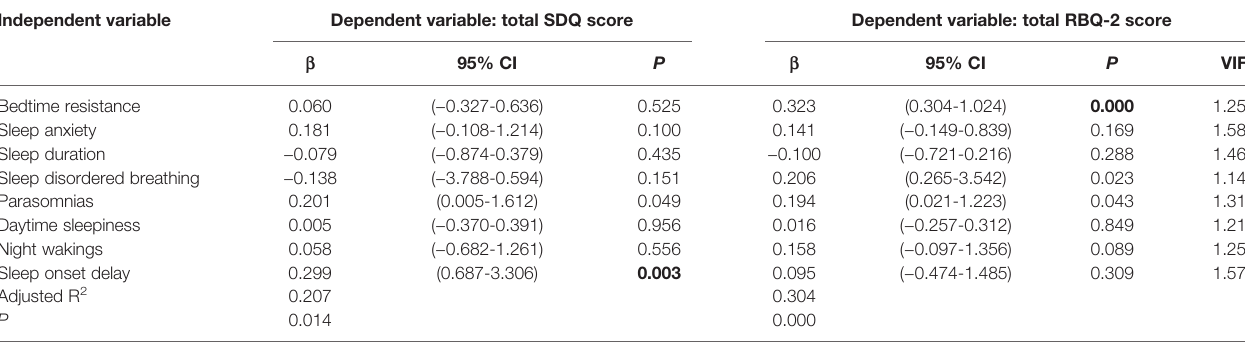
TABLE 7 | Multiple linear regression analysis of CSHQ subscales as independent variables. Independent variable Dependent variable: total SDQ score